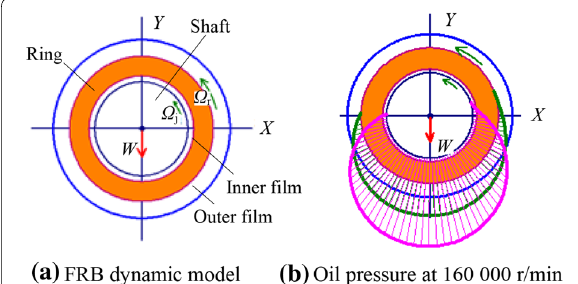
Figure 2 Dynamic model of FRB and its oil pressure